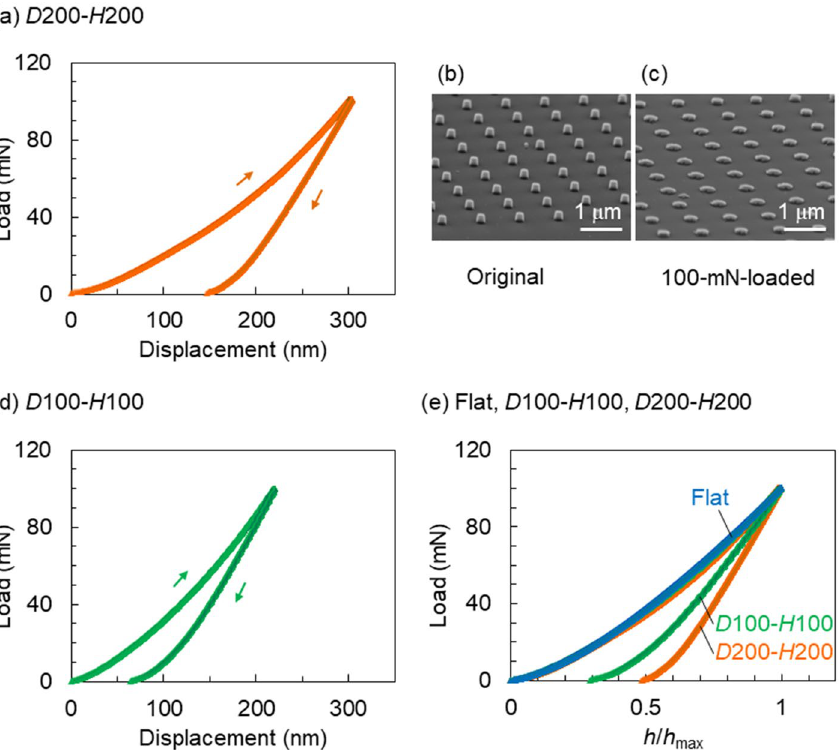
Figure 3. Load–displacement curves of the ( a ) D 200– H 200 and ( d ) D 100– H 100 SQ nanopillar surfaces. ( b , c ) Tilted SEM images of the ( b ) original D 200– H 200 SQ nanopillars and ( c ) the pillars after deformation at a peak load of 100 mN. ( e ) Relationship between the normalised displacements ( h / h max ) and loads measured for SQ with a flat surface, as well as with the D 100– H 100 and D 200 –H 200